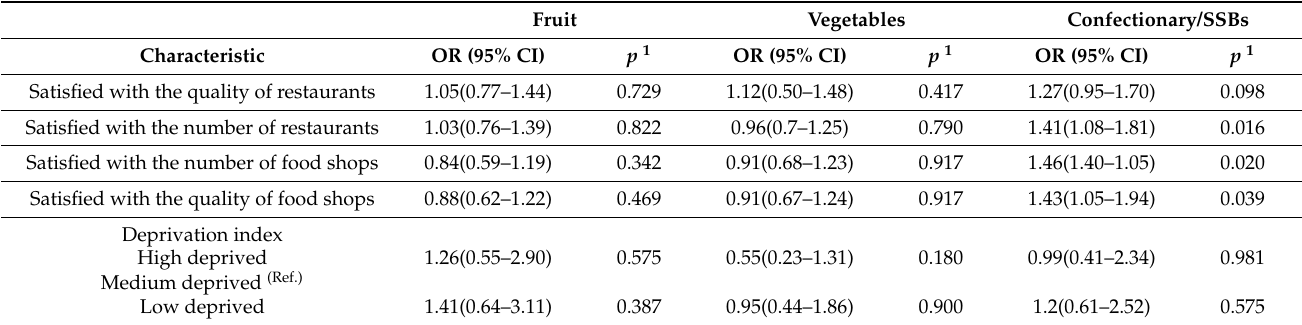
Table 4. Logistic regression models for parents’ satisfaction with neighborhood food environment, deprivation index, and children’s fruit, vegetable, and confectionary/SSB